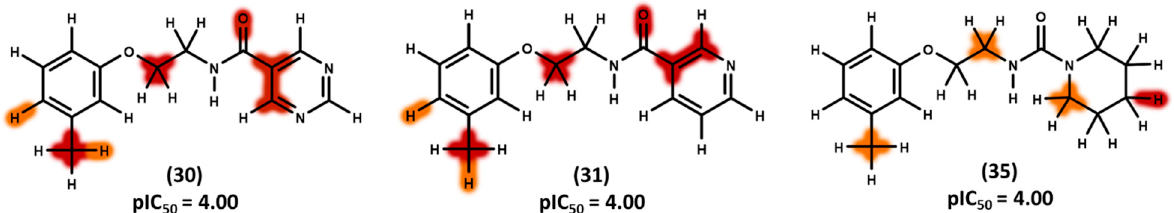
Figure 7. Contribution maps for compounds that had the imidazole ring replaced by other rings, highlighting the detrimental